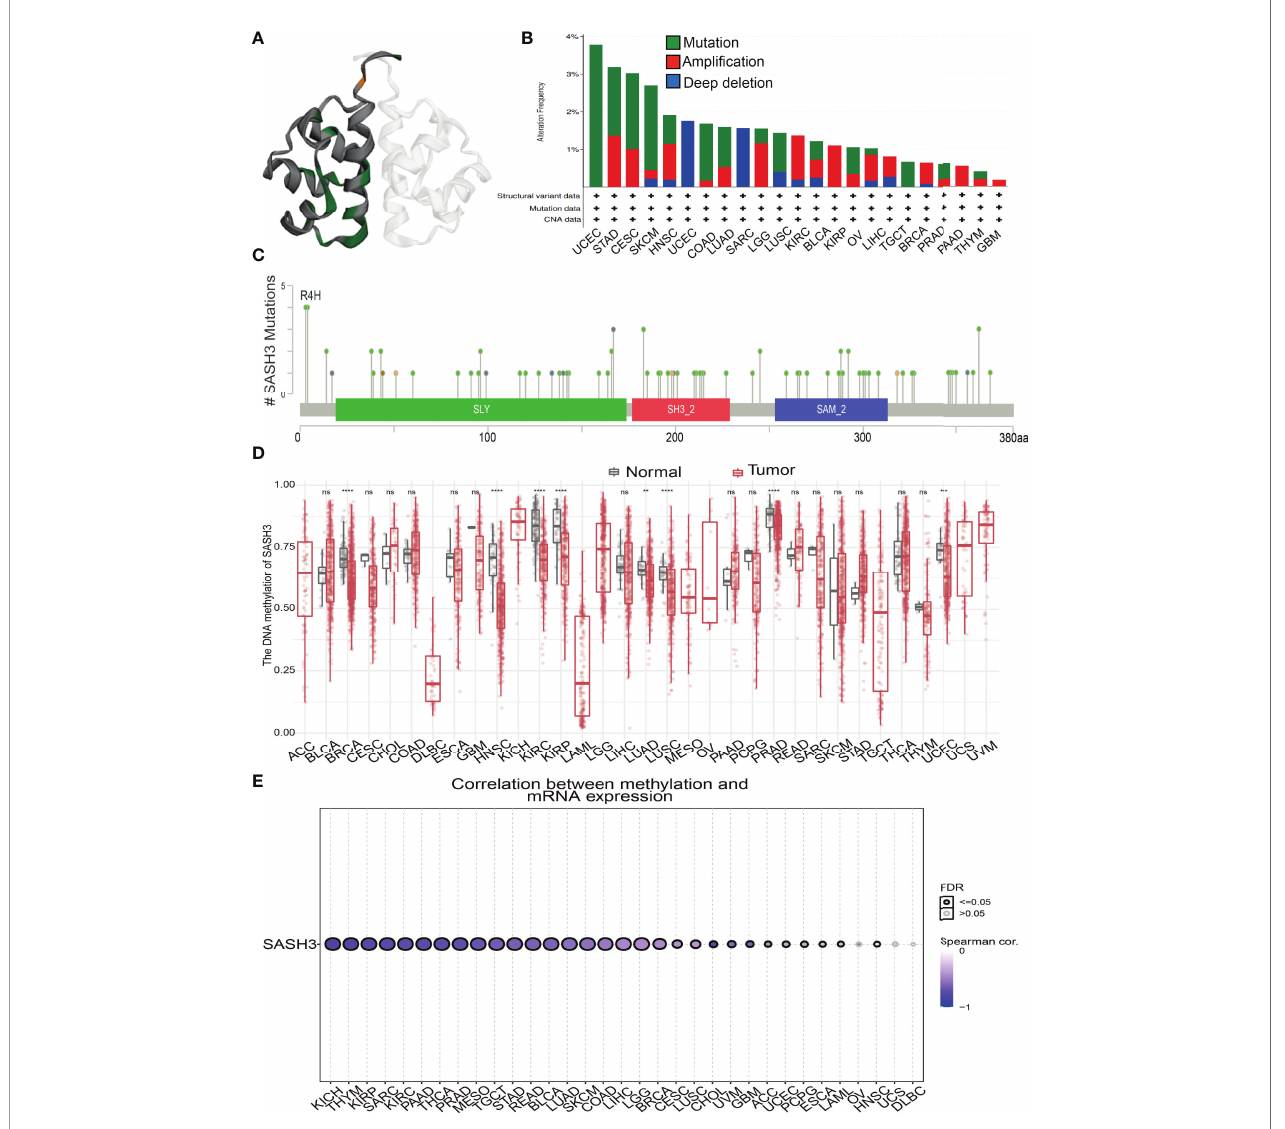
FIGURE 6 | Mutational analysis of SASH3. (A) 3D structure of SASH3 gene transcript. (B) Summary of mutation types of SASH3 (structural variant data, mutation data, and copy number variant data) and the distribution among different cancers. (C) Hot spots of mutation of SASH3. (D) The DNA methylation level of SASH3 in pan-cancer. (E) Correlation between DNA methylation level and SASH3 expression in pan-cancer. ** p <0.01, *** p <0.001, **** p < 0.00001, NS,